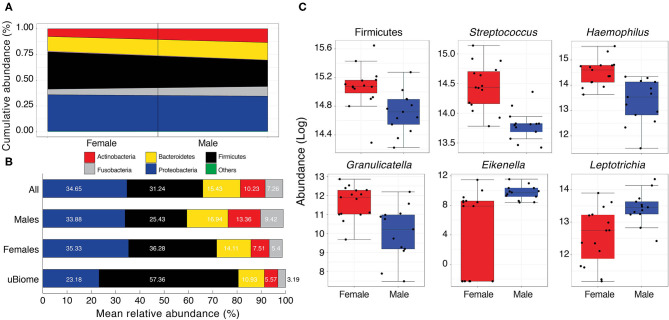
(A) Cumulative abundance (%) of major phyla detected in the Pakistani oral samples. Black line separates male and female samples. Others category includes Spirochaetes, Cand. Saccharibacteria, and Synergistetes (see Table S7 for actual values) (B) Comparison of mean relative abundance (%) of major phyla detected in the oral cavity of Pakistani males and females vs. uBiome dataset. Numbers on bars indicate actual percentages. (C) Boxplots comparing phyla and genera with significant differential abundance in males and females (Wilcoxon rank-sum test, FDR < 0.05).